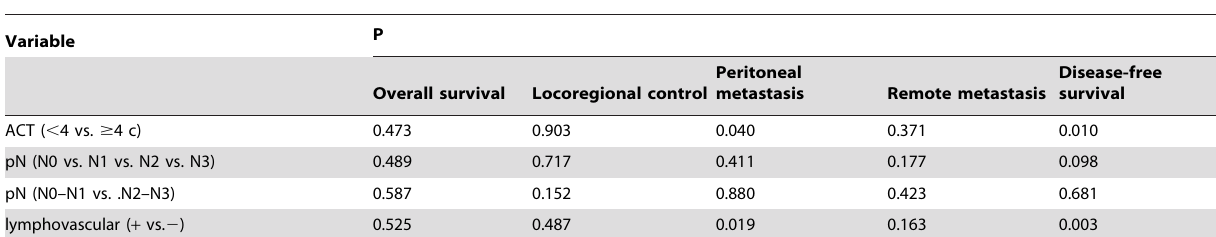
Table 3. Multivariate analysis of local control, disease-free survival, and overall survival.